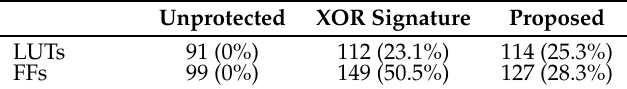
Table 2. Utilization Report (Series).